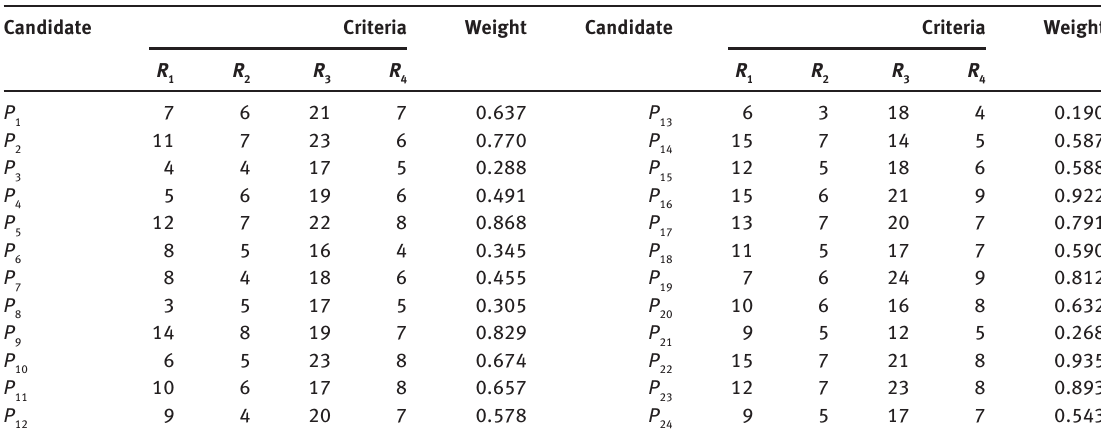
Table 2: Original Data and Node Weights of Candidates Candidate Criteria Weight Candidate Criteria Weight R 1 P